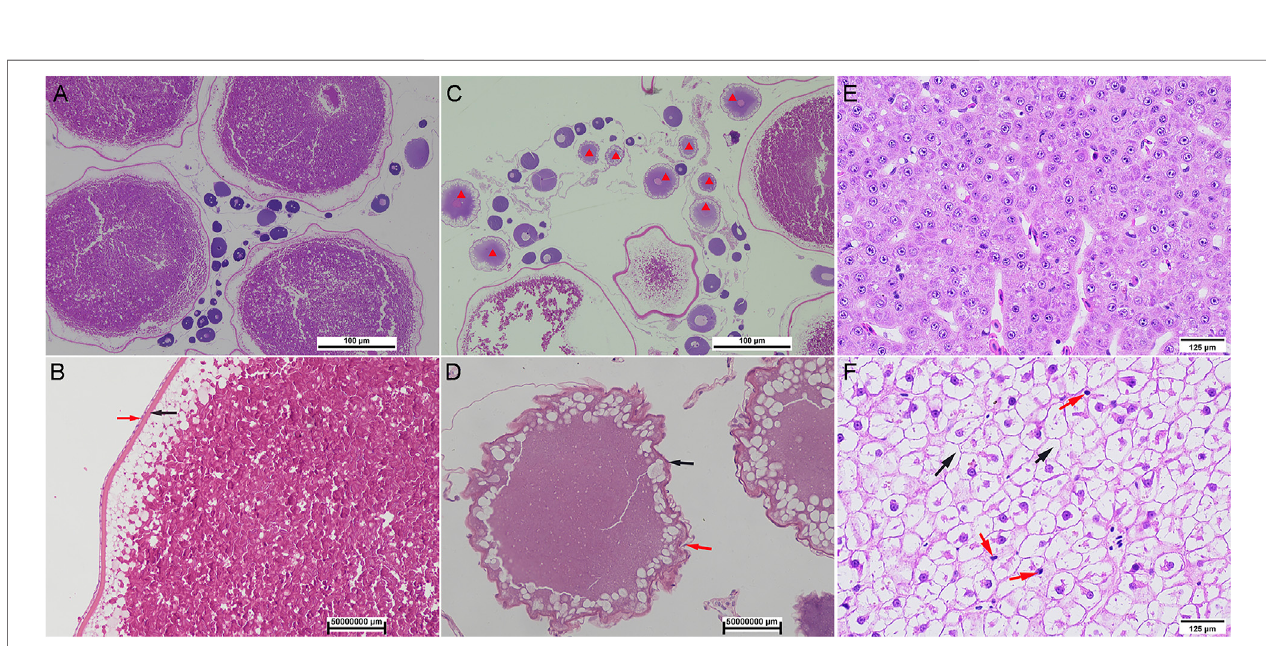
FIGURE 1 | Gross morphology of S. o ’ connori , ovary, and ovum between wild and captive-reared group. (A) A photograph ofwild S. o ’ connori . (B) A photograph of captive-reared S. o ’ connori . The ovary (C) and ovum (E) of wild S. o ’ connori . The ovary (D) and ovum (F) of captive-reared S. o ’ connori .